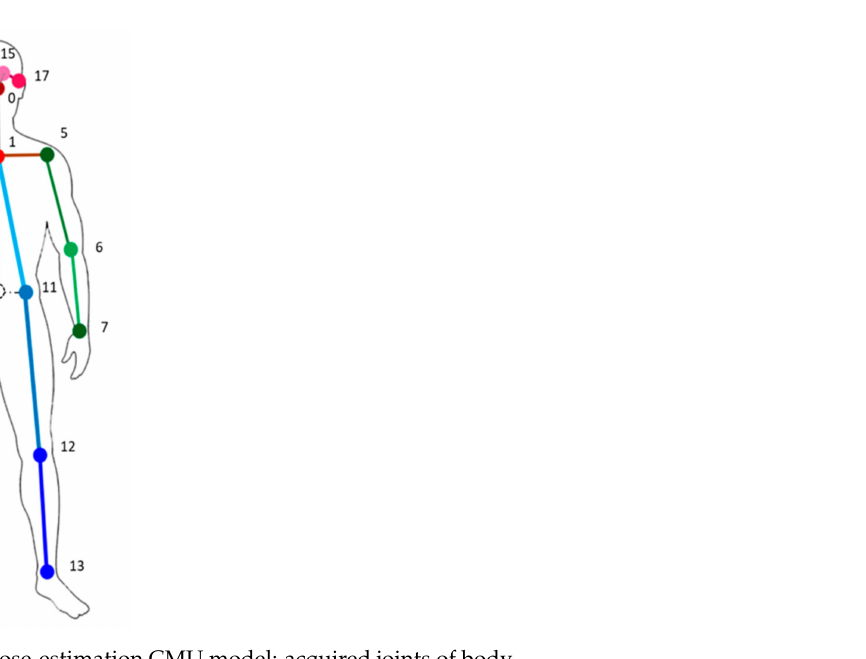
Figure 2. tf-pose-estimation CMU model: acquired joints of